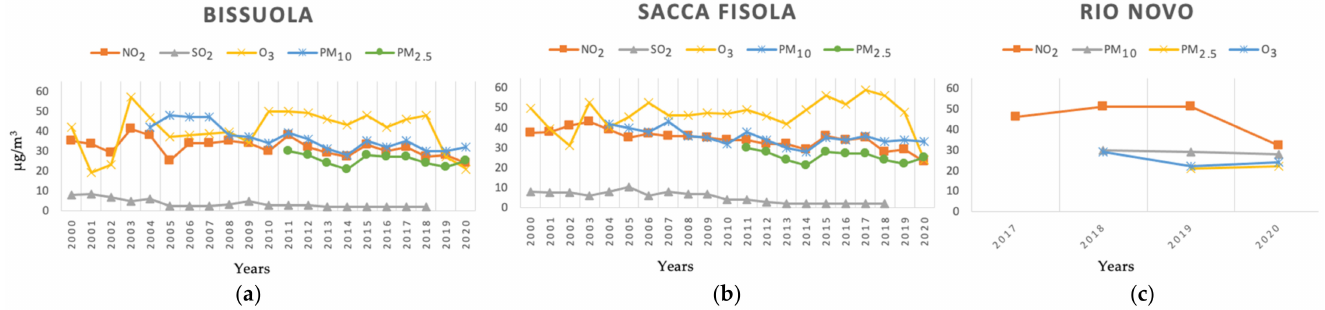
Figure 4. Trend of annual average pollutant concentrations of NO 2, SO 2 , O 3 , PM 10 , PM 2.5 collected from the stations of: ( a ) Bissuola; ( b ) Sacca Fisola; ( c ) Rio Novo. Comparisons among the data collected in the different stations signify the background green area (Bissuola), background urban area (Sacca Fisola), and intense water-traffic area highlighted slightly higher PM 10 values in Bissuola and higher O 3 values in Sacca Fisola, while NO 2 is similar for the background stations but locally high in Rio Novo, near the